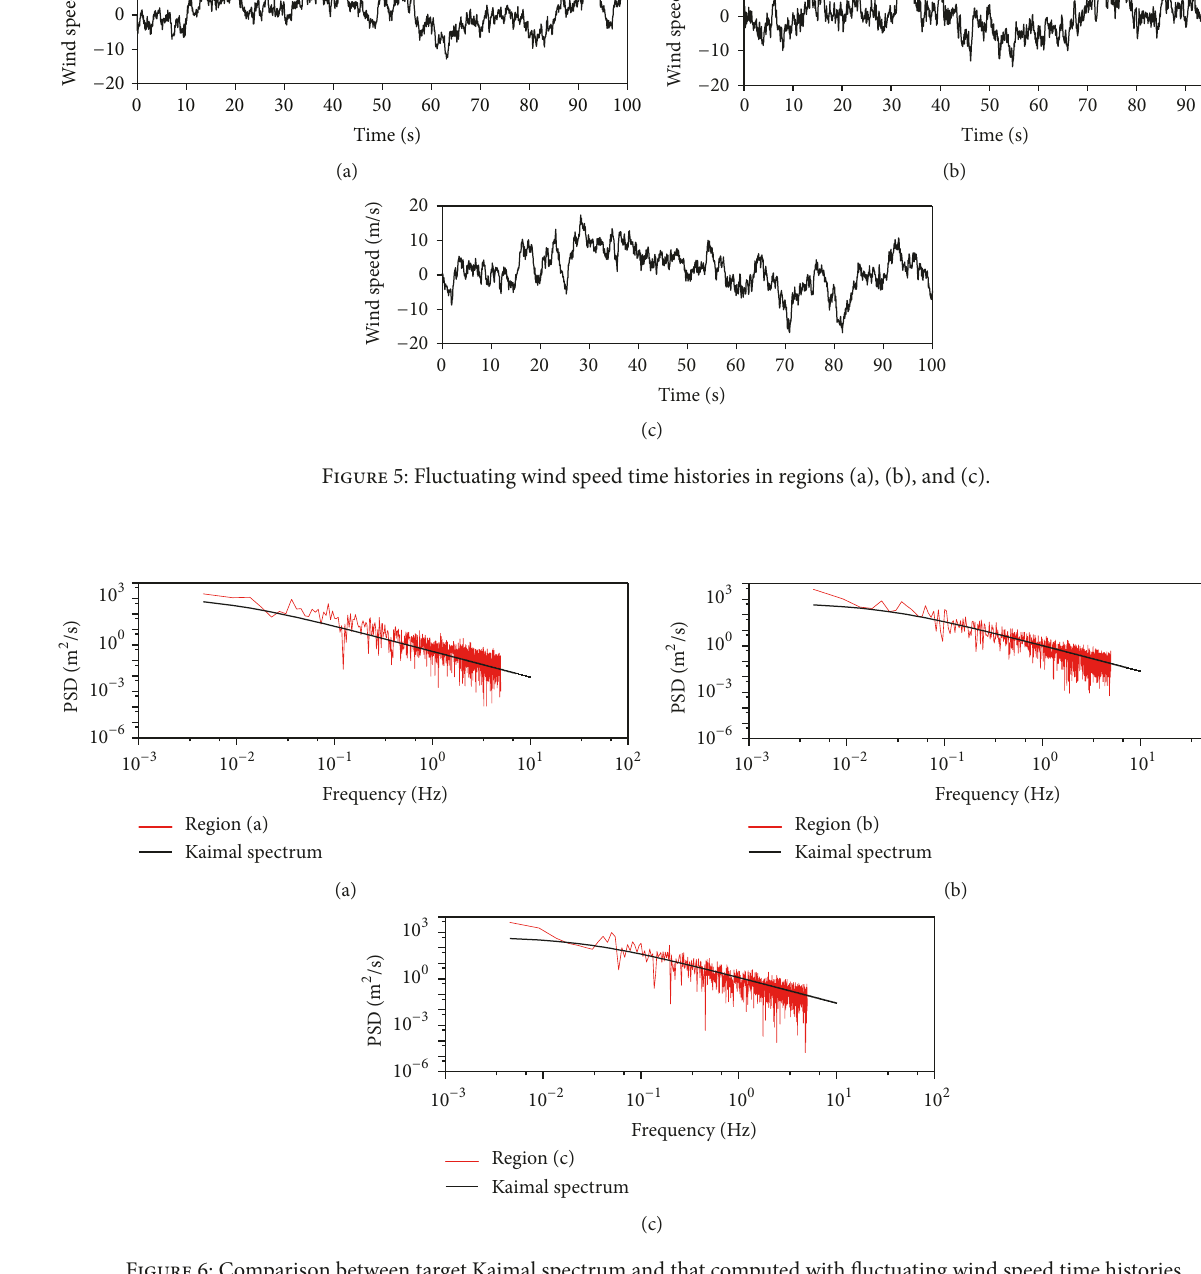
Figure 6: Comparison between target Kaimal spectrum and that computed with fluctuating wind speed time